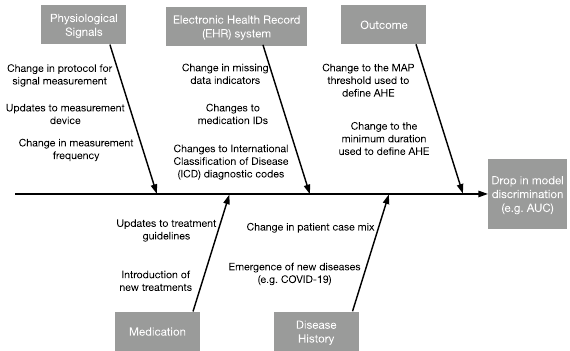
Fig. 2 Cause-and-effect diagram for a drop in performance of an AI-based early warning system for Acute Hypotension Episodes (AHEs). Each branch represents a category of potential causes. The effect is de fi ned as model performance, which is measured by the area under the receiver operating characteristic curve